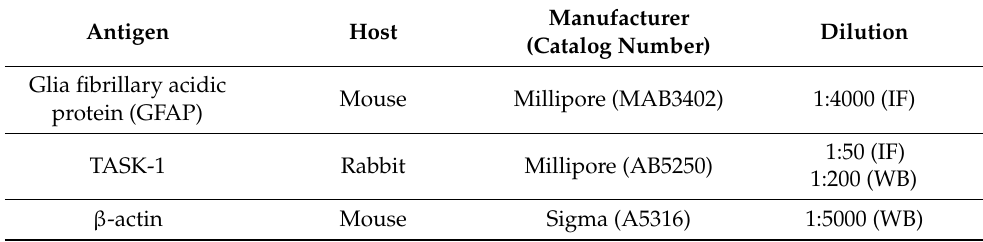
Table 2. Primary antibodies used in the present